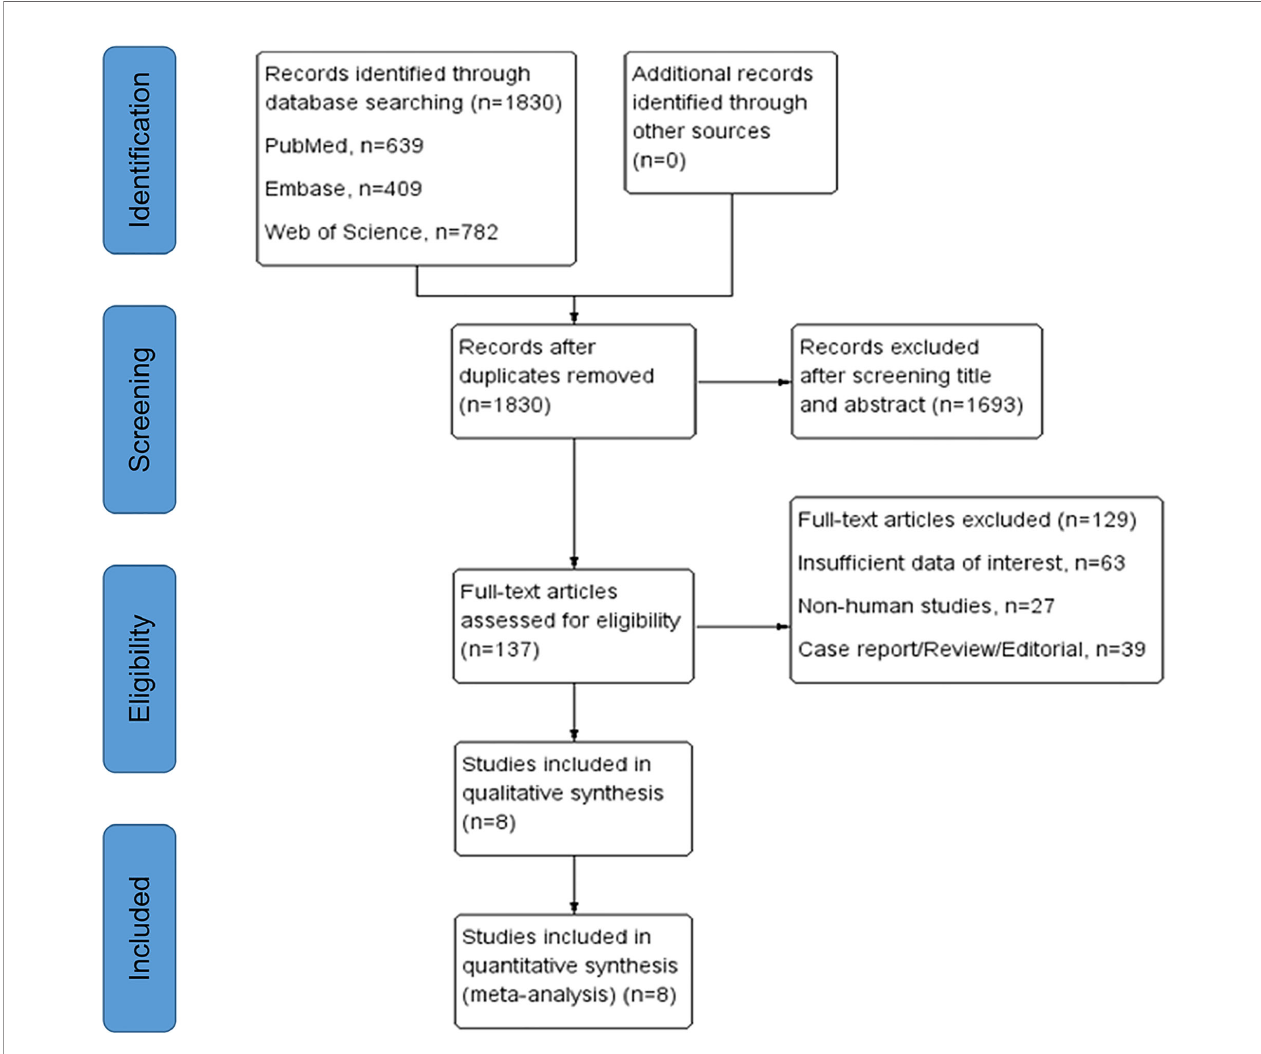
FIGURE 1 | PRISMA fl owchart for study selection